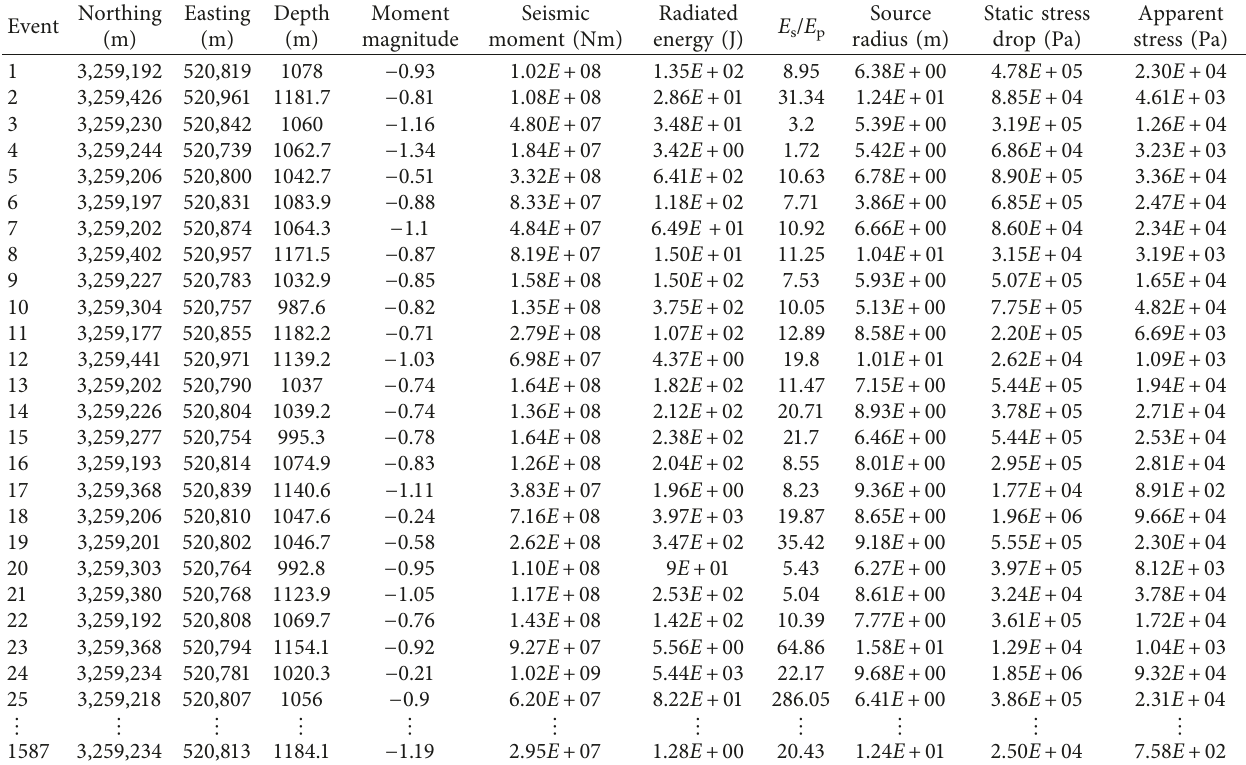
Table 1: Seismic source parameters of typical blasting